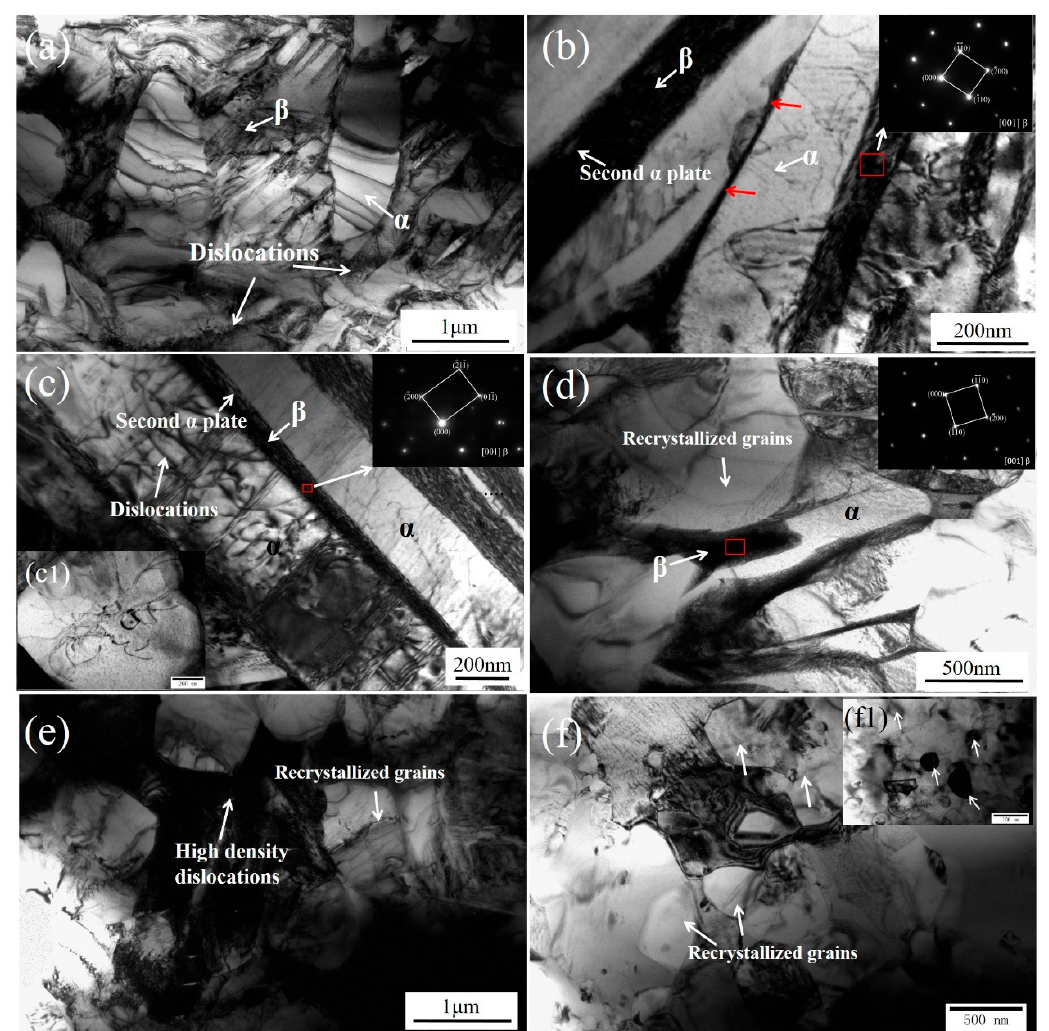
Figure 4. TEM images of the stir zone for FSP225 sample (about 0.5 mm~1.2 mm from the upper surface): The distances of ( a ), ( b ), ( c ), ( d ), ( e ) and ( f ) from upper surface gradually decrease. The Figure c1